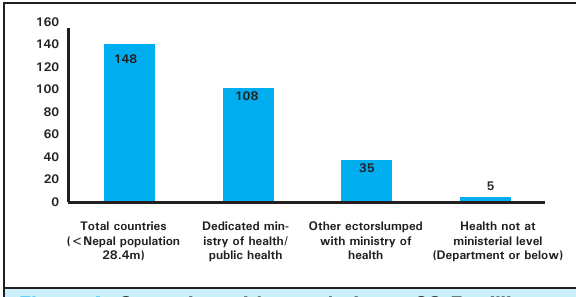
Figure 4. Countries with population ≤28.5 million vs ministries of health.